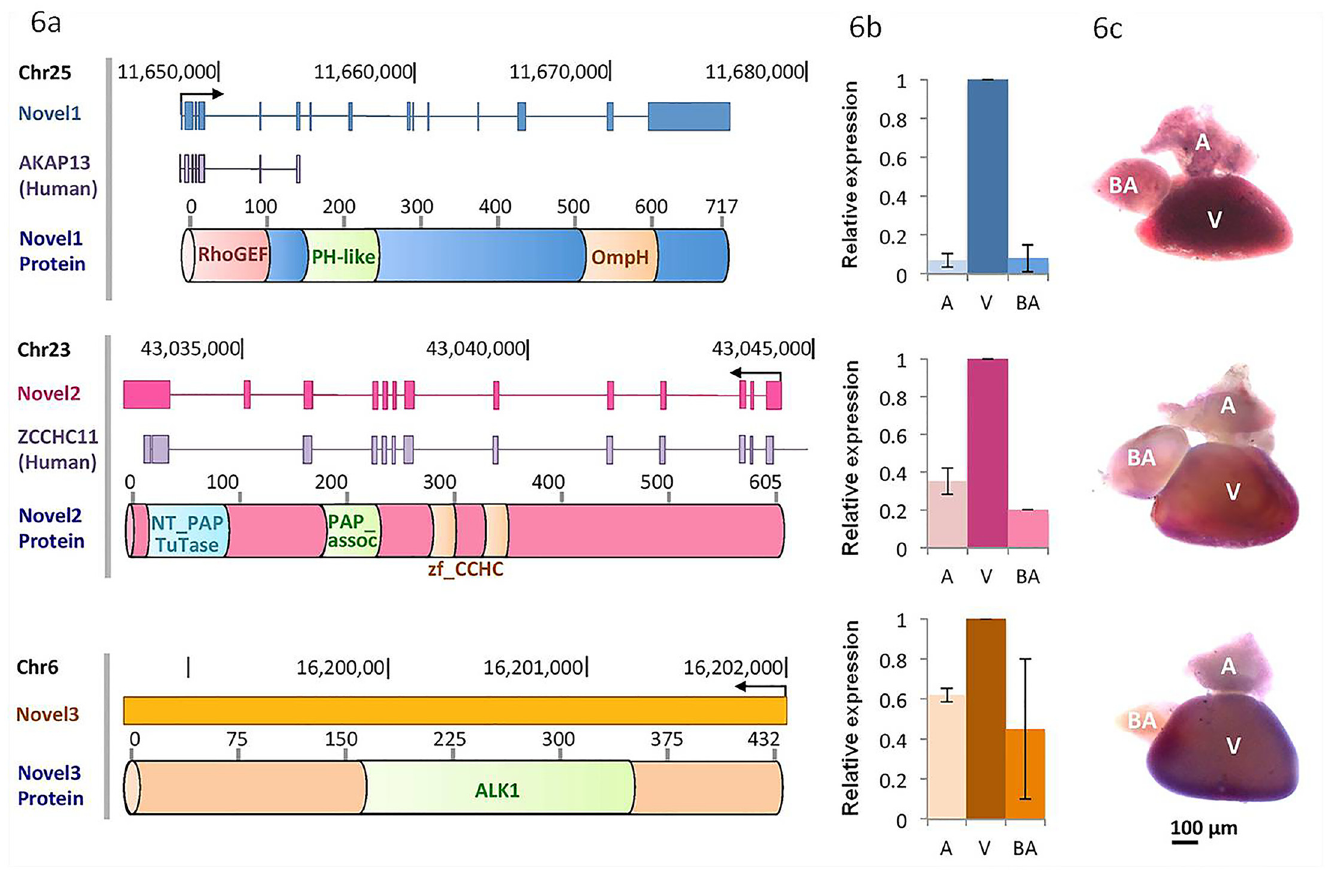
Fig 6. Experimental validation of top ventricle-restricted putative novel protein coding genes. (A) Putative exon structure, human protein homologs and protein domain architecture of the candidate novel protein coding genes. (B) Validation of ventricle-restricted protein coding gene candidates using qRT-PCR. (C) Validation of ventricle-restricted protein coding gene candidates using WISH. XLOC_170573 (Novel 1), XLOC_159758 (Novel 2) and XLOC_215980 (Novel 3) show restricted expression in the ventricle. Scale bar: 100 μ m. A (Atrium); V (Ventricle) and BA (Bulbous